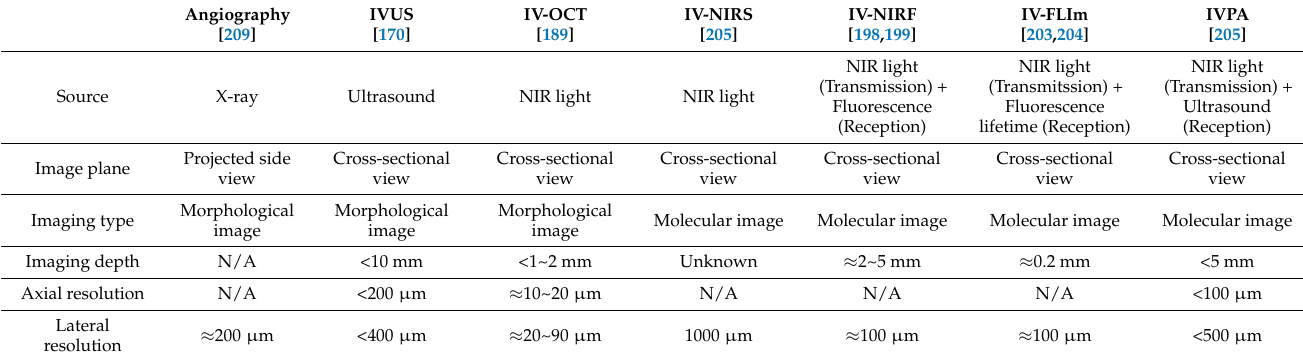
Table 4. Performance comparison of atherosclerosis imaging